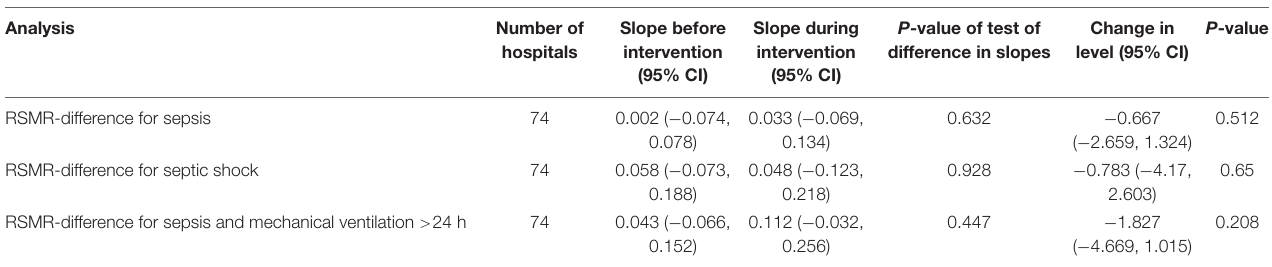
TABLE 2 | Results of interrupted time-series analyses on risk-standardized mortality rate difference between GQNS hospitals and the national diagnosis-related groups statistics.